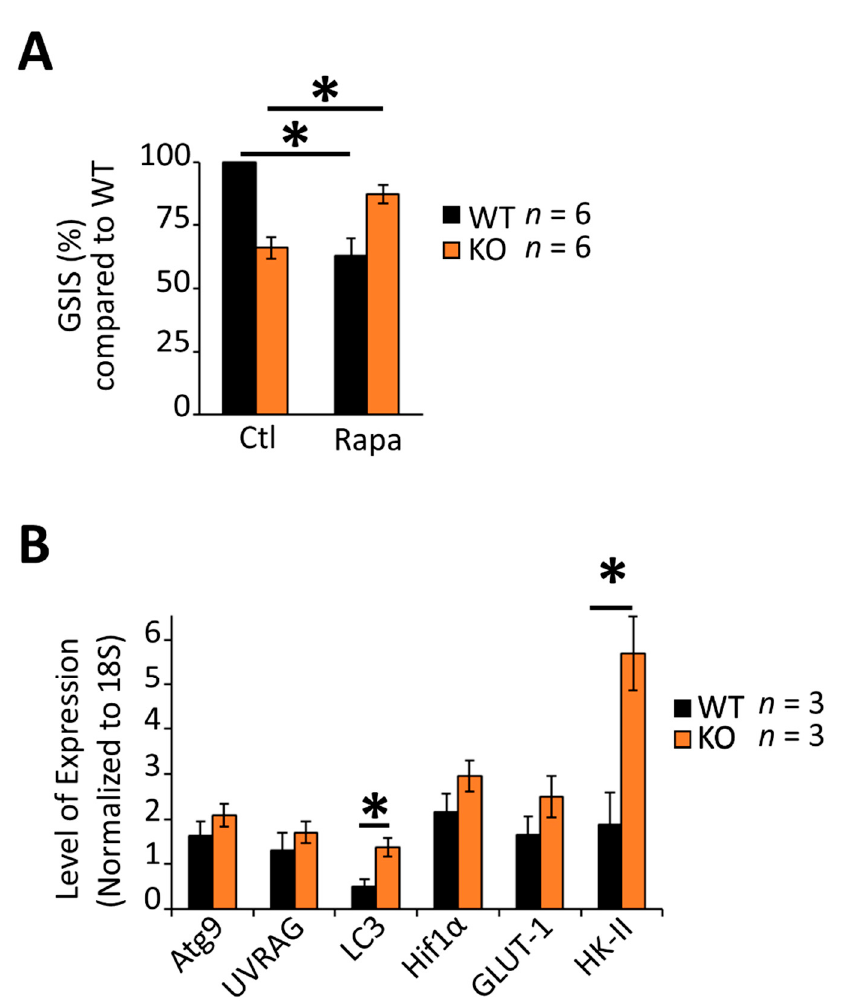
Figure 4. Altered glucose responsiveness is associated with dysregulation of the MTOR-C1 pathway and glucose homeostasis gene expression in RGS4-deficient islets. ( A ) Glucose-stimulated insulin secretion (GSIS) was measured in isolated islets from WT and RGS4-KO mice following 30 min glucose challenge (20 mM) with and without the addition of the MTORC1 inhibitor rapamycin (50 nM). Data are expressed as GSIS% relative to that for WT islets. ( B ) qRT-PCR analysis of mRNA expression of select genes related to autophagic or glucose homeostasis in WT and RGS4-deficient isolated islets. * p < 0.05; [one-way ANOVA and Tukey’s post-hoc test ( A , B )]. G α i/o inhibition using Bordella pertussis toxin (PTx) is known to enhance insulin se- cretion from β -cells [27,43,67–69]. We asked whether RGS4 ′ s role in maintaining glucose stimulated insulin secretion may also be linked to its biochemical activity as a G α i/o in-